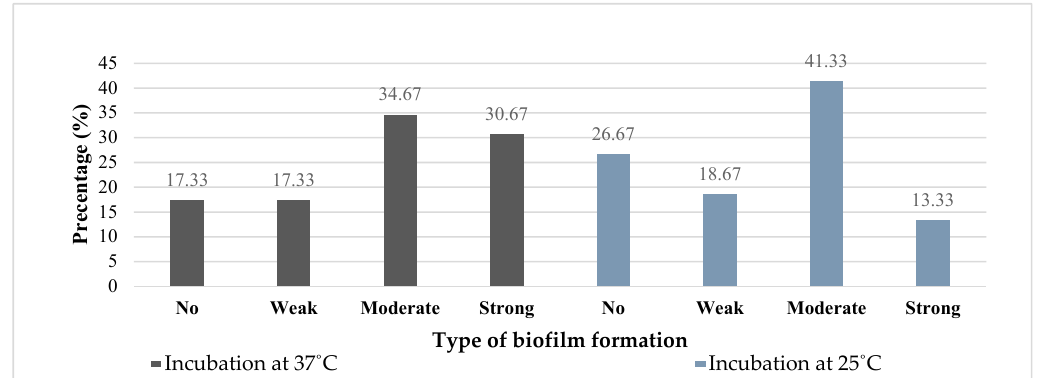
Figure 4. Percentage of Pseudomonas aeruginosa according to biofilm ability.